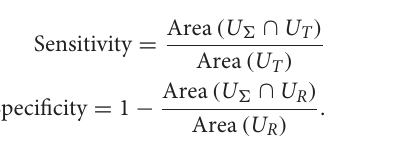
calculate the sensitivity and